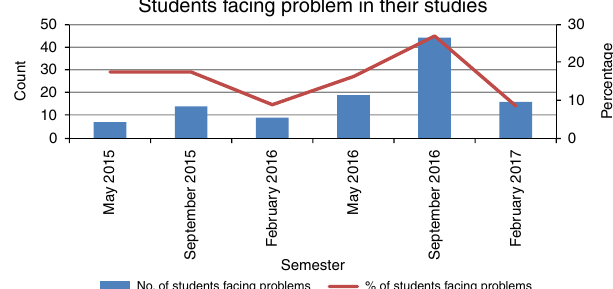
Figure 1. Percentage and